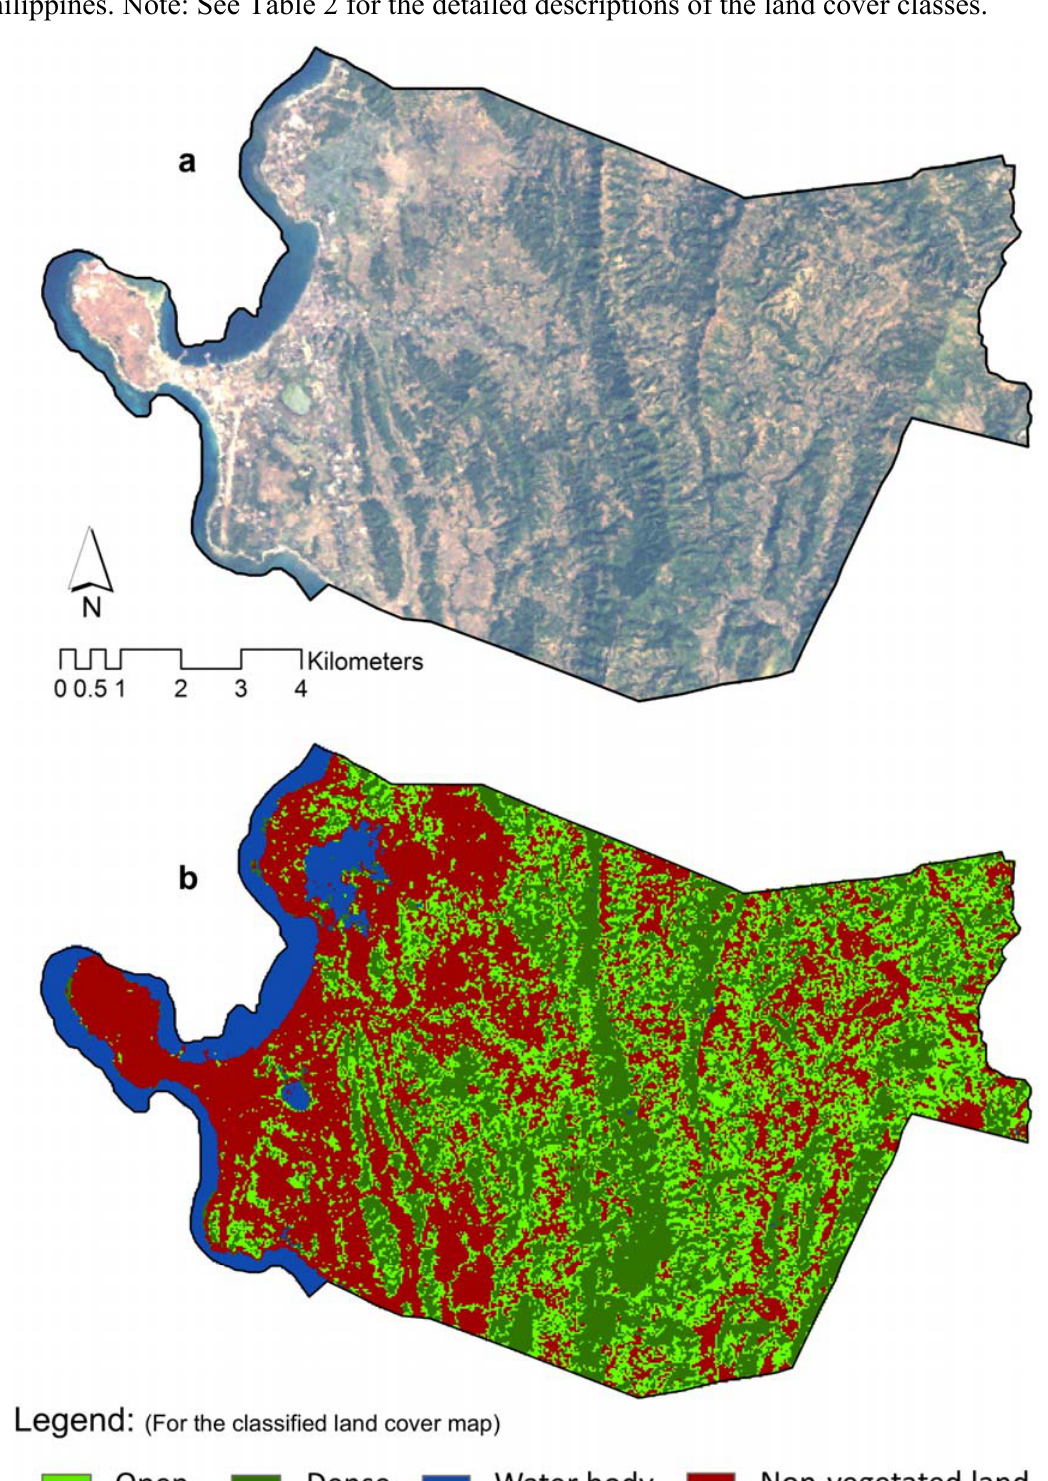
Figure 4. ( a ) The 1989 Landsat image displayed in its “true colour” composite (RGB:321). ( b ) The 1989 classified land cover map of the City of San Fernando, La